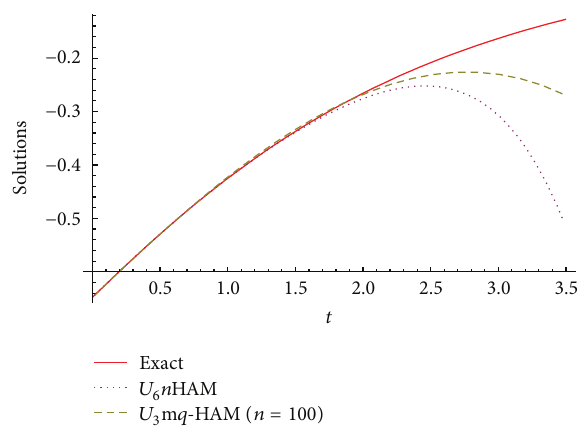
Figure 17: The comparison between the 𝑈 3 of m 𝑞 -HAM (𝑛 = 100) , 𝑛 HAM (m 𝑞 -HAM; 𝑛 = 1) , and the exact solution of (40) at 𝑈 6 of (ℎ = −79.5, ℎ = −1) and 𝑥 = 1 .